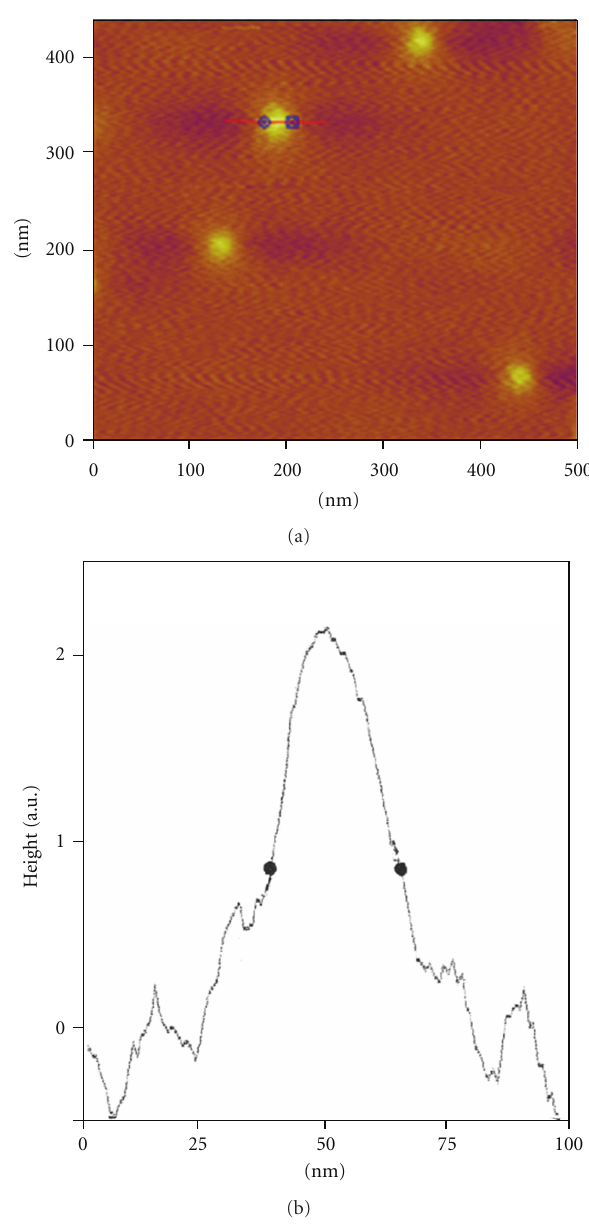
Figure 2: Atomic force micrograph reveals particles (a) of approxi- mately 30nm in size from scanning trace